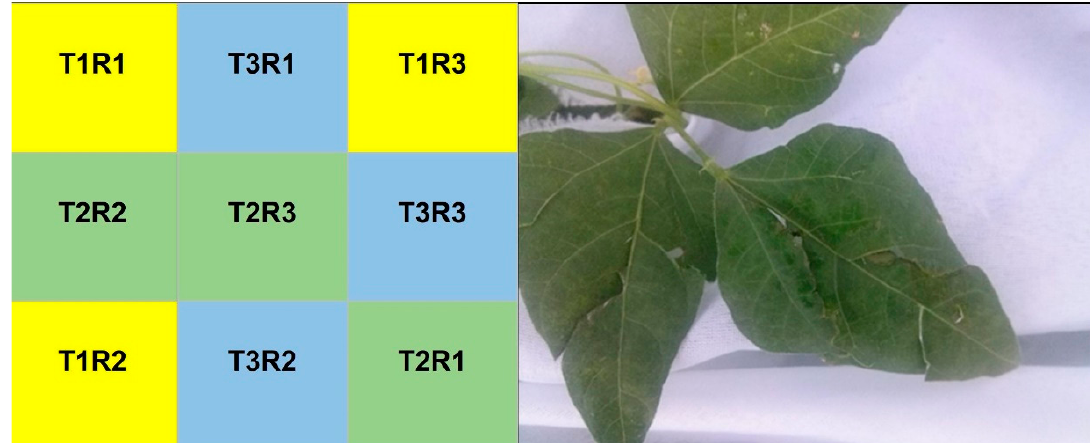
Figure 3. Distribution of experimental blocks and mechanical leaf damage. The image on the ( left ) side shows the distribution of the randomized experimental blocks with 3 replicates. T1 = control group, T2 = mechanical damage was inflicted on 50% of the leaves and T3 = mechanical damage was inflicted on 80% of the leaves; R1, R2 and R3 are the repetitions of each treatment. The image on the ( right ) side shows how the mechanical damage was inflicted, by manually breaking a third of the Tepary bean leaf blade in the midrib area, without separating the petiole from the stem.